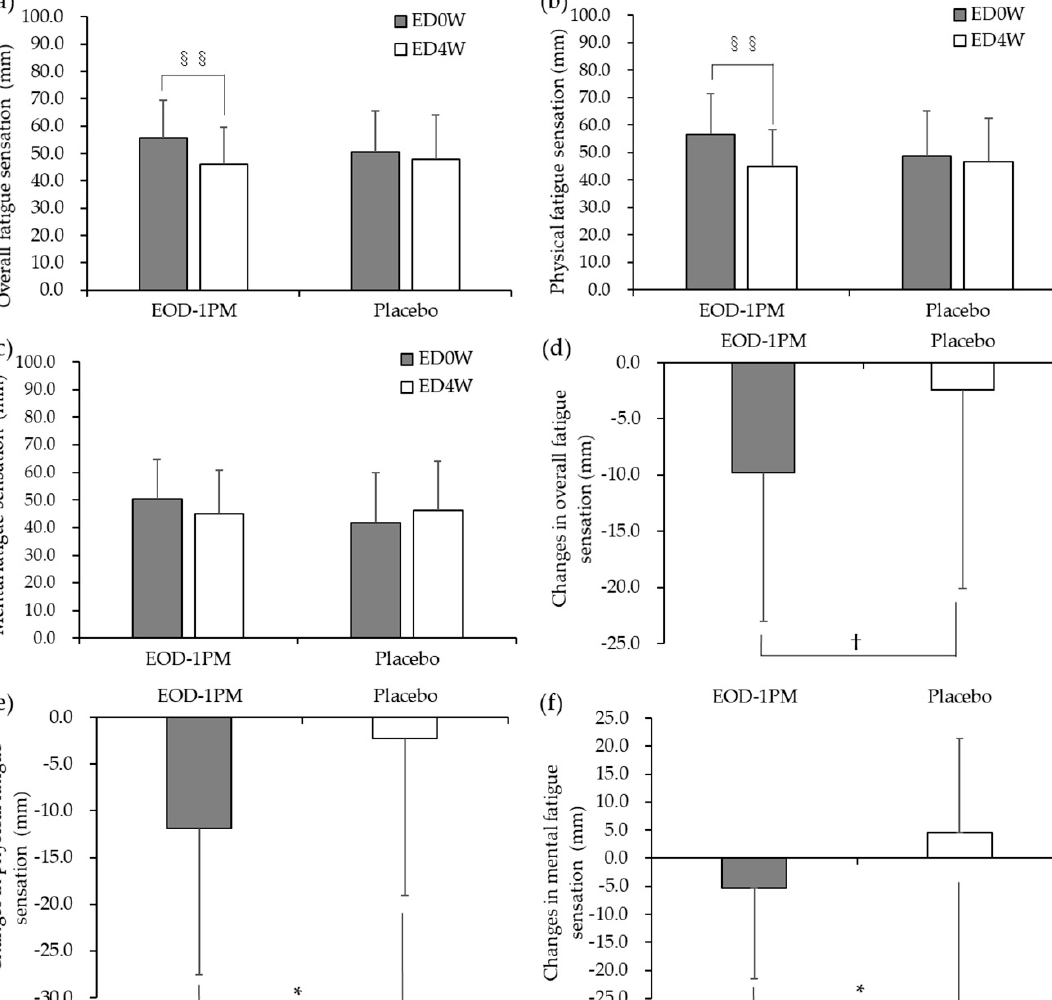
Figure 3. Evaluation of fatigue sensation by using VAS upon arrival to the facility on the examination day. ( a ) Comparison of overall fatigue sensation on the examination day at 0 weeks (ED0W) and at 4 weeks after the start of the intake (ED4W); ( b ) comparison of physical fatigue sensation on the ED0W and ED4W; ( c ) comparison of mental fatigue sensation on the ED0W and ED4W ; ( d ) comparison of changes in overall fatigue sensation before and after the intake; ( e ) comparison of changes in physical fatigue sensation before and after the intake; and ( f ) comparison of changes in mental fatigue sensation before and after the intake. EOD-1PM group: n = 25, placebo group: n = 27. §§ p < 0.01. Comparison with that at facility arrival on the ED0W. * p < 0.05, † p < 0.1. Comparison between the placebo and EOD-1PM groups. The data are presented as the mean ± standard deviation.